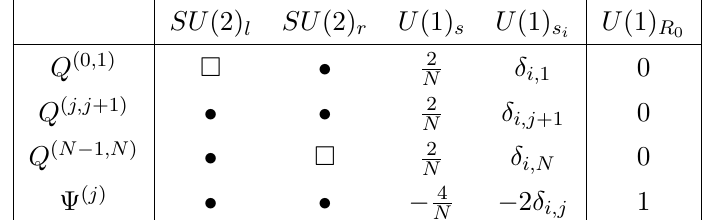
Table 7 . Transformation rules under the global symmetry of the 2 d matter fields coming from the dimensional reduction of theory T 4d B